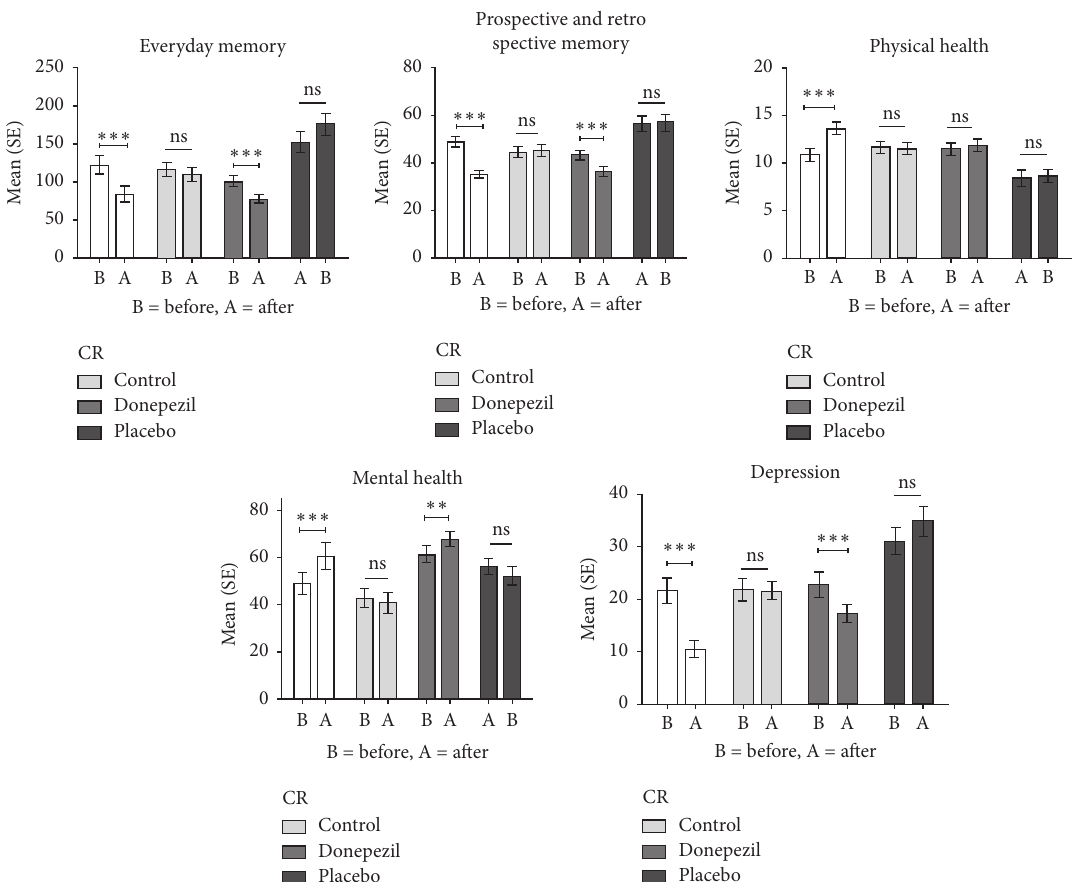
Figure 1: Comparison of pretests-posttests of cognitive rehabilitation, control, donepezil and placebo on memory performance, attention, quality of life, ns: not significant. Table 2: Results from multivariate analyses of covariance (MANCOVA) comparing scores of posttests between groups.